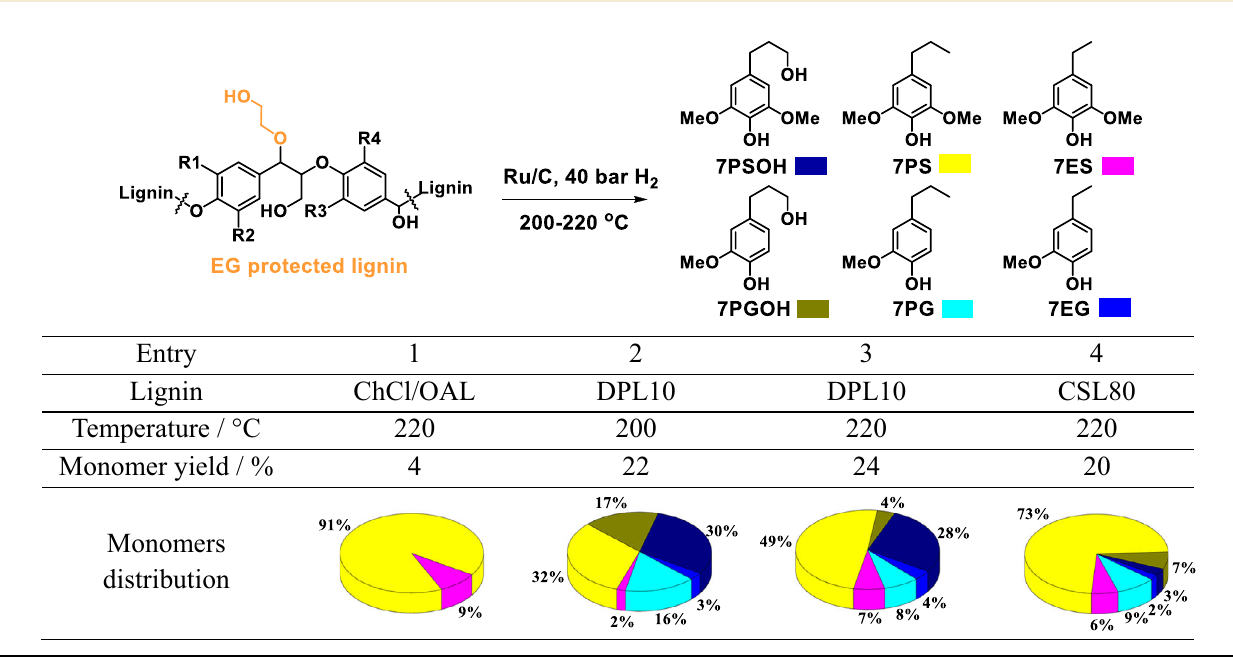
Table 2 Monomers yield and distribution of hydrogenolysis